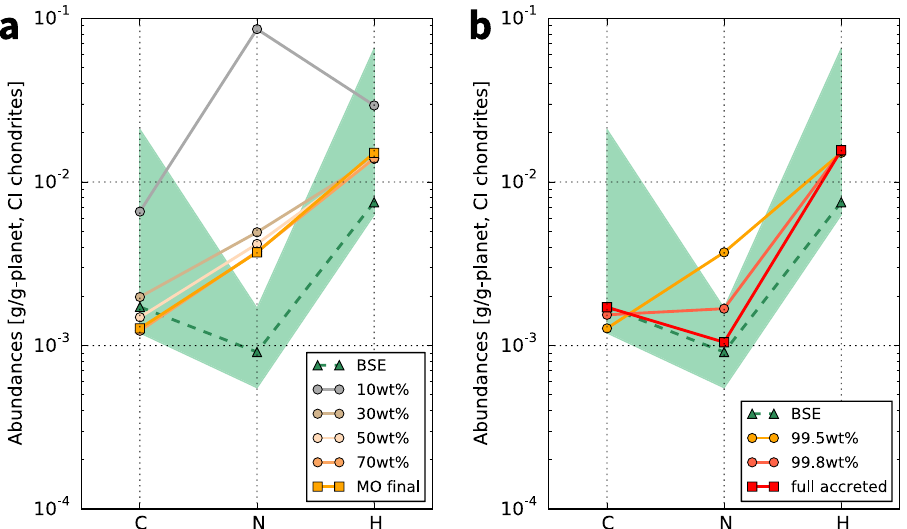
Figure 2. Evolution of major volatile abundances in the bulk silicate Earth (BSE) scaled by those of CI chondrites in the nominal model. The abundances are normalized by each planetary mass at each time for ( a ) the main accretion stage, from 10 to 99.5% of Earth’s accretion, and ( b ) the late accretion stage defined as the last 0.5% of accretion after the magma ocean solidification. The time sequence is shown by lines from top to bottom with snapshots. The thick orange and red lines correspond to the end of main and late accretion stages, respectively. The range in the current BSE composition estimate 4,5,17 is shown for comparison (green area). The mean value of Hirschmann 5 is shown as a reference for the relative depletion pattern (green line). See Table 1 for the composition of BSE and chondrites.